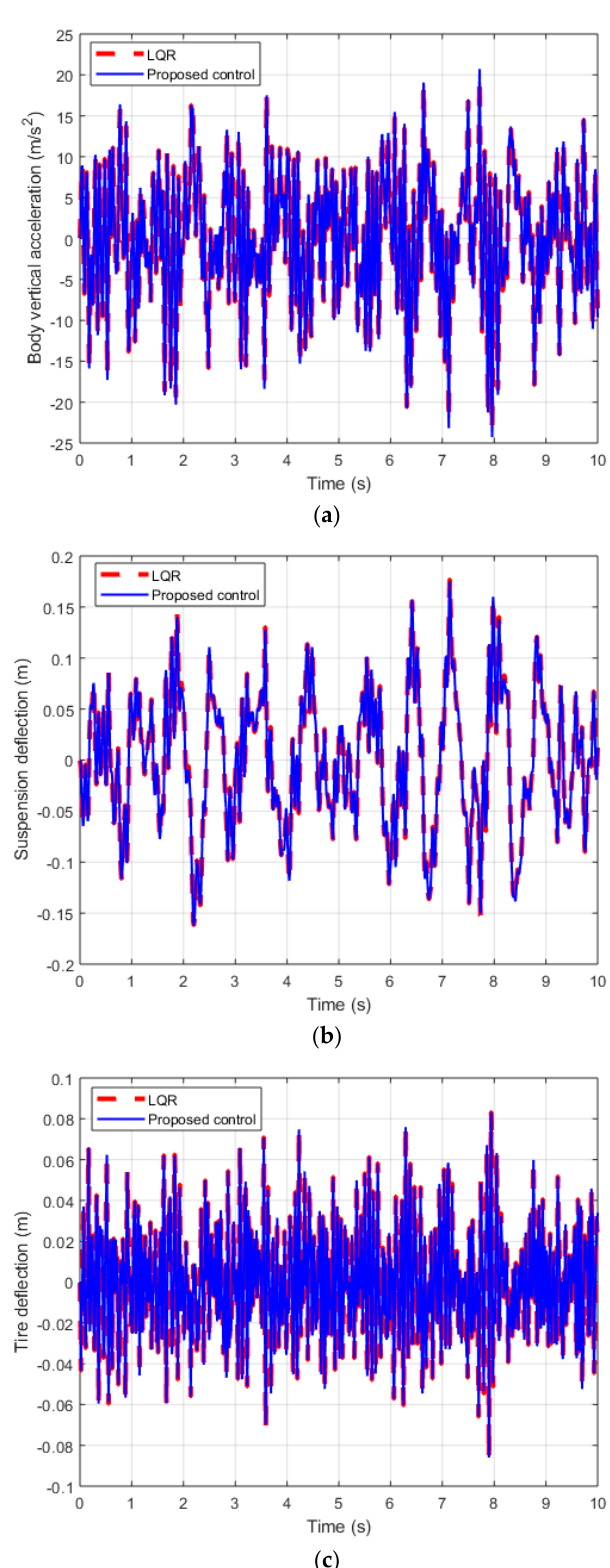
Figure 4. Performance index comparison between the proposed control and the LQR. ( a ) Body vertical acceleration; ( b ) suspension deflection; ( c ) tire deflection.